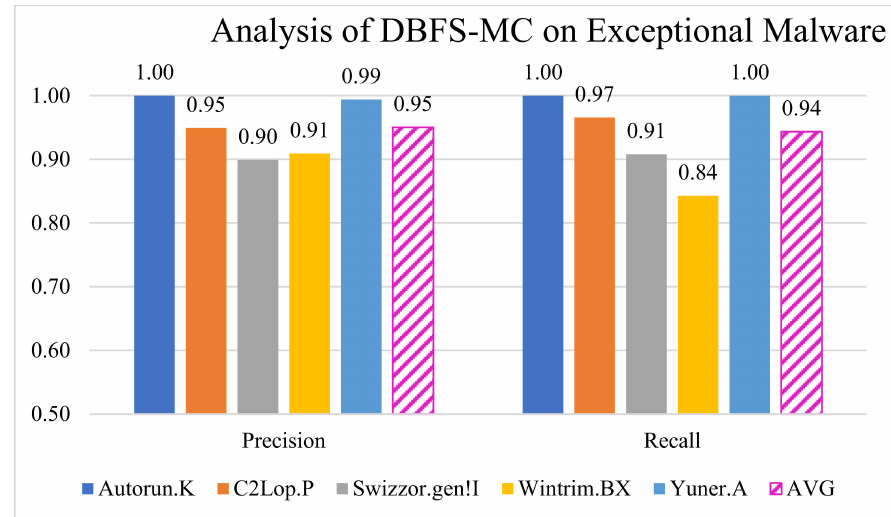
Figure 10. Performance of DBFS-MC for exceptional